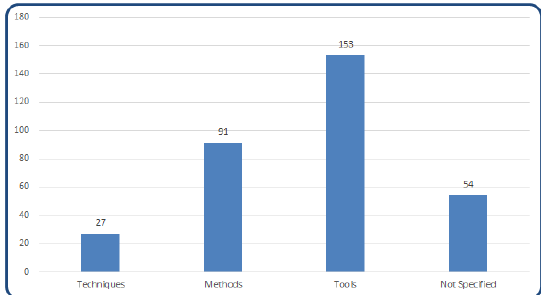
Figure 5. Results of RQ2: innovation type.